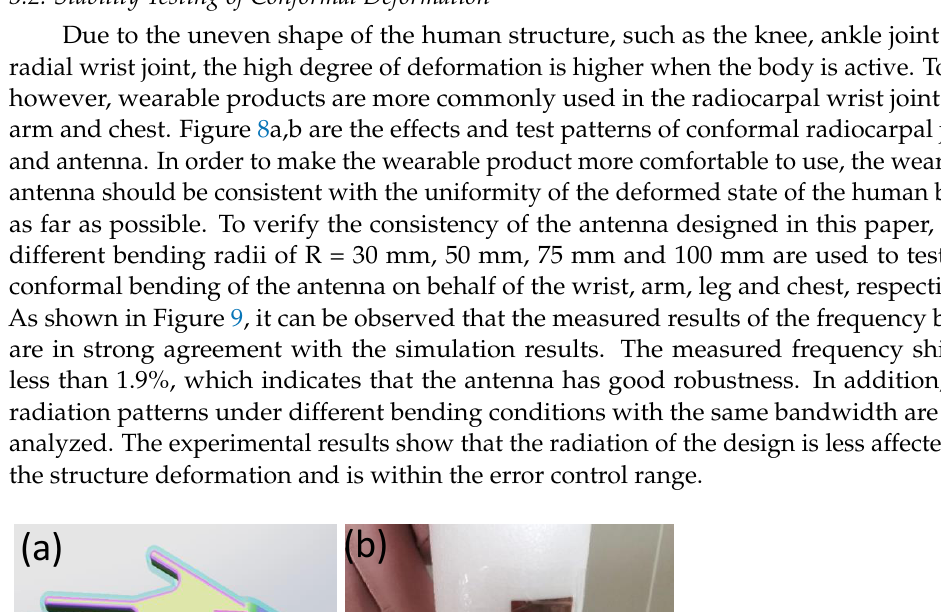
Figure 9. Simulation test results under different radii of curvature . 3.3. Safety Assessment of Body-Worn Antenna In addition to the above confirmatory test, the designer also needs to consider an important safety factor, that is, the proposed antenna will leak electromagnetic radiation into the human body, which will expose the human body to health risks. Therefore, the specific absorption rate (SAR) of the antenna needs to be evaluated to ensure the health and safety of the wearer. A human tissue model is designed in CST, which is composed of skin, fat and muscle, to approach the real human body. The proposed antenna is placed at the height of 3 mm above the simulated tissue. The receiving power of the antenna is set to 0.5 W as a reference. The software simulates the comparison of the SAR data gener- ated by the antenna with the human standard SAR data in band of 2.42 GHz, 5.752 GHz and 9 GHz. The SAR evaluation is conducted using the IEEE C95.1 standard available in the CST MWS software. The software simulation results are compared with average SAR data and the current distribution, as shown in Figure 10. The results show that the peak SAR results at 2.42, 5.72 and 9 GHz were found to be equal to 0.938, 1.15 and 1.46 W/kg, respectively, which conform to the SAR requirement of lower than 2 W/kg. These results further high- light the superiority of the proposed antenna for on-body applications.